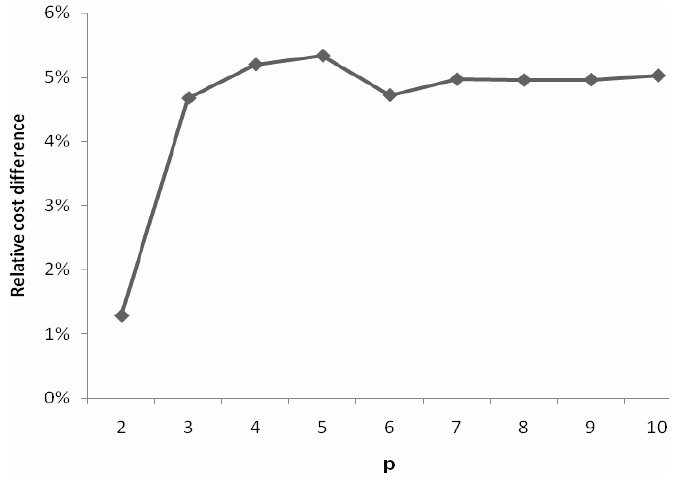
Figure 13. Relative cost difference Hubs are for the time being located in Metz, Villeneuve St. Georges (Paris), Schaerbeek (Brussels), Koln, Hannover and Mannheim, thus in the North of Europe. Ballis (2002), also pointed out that a hub nearby Milan would be useful. In other words, Ballis concludes that a 7 hubs configuration would be an interesting one. Figures 14 and 15 represent the 7 hubs that we obtained by minimizing (16) using data corresponding to the selected potential locations and the Ward aggregated nodes respectively. The set of hubs obtained using the 34 potential locations that result from the selection approach is similar to the topology described by Ballis, which is not the case for the hub locations calculated on the basis of the 34 nodes obtained by